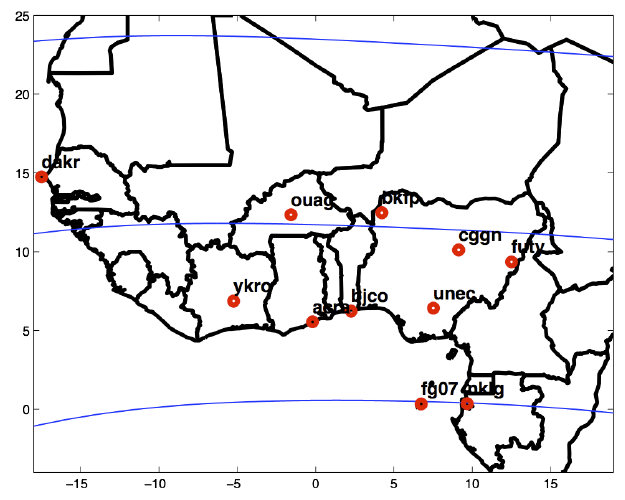
Figure 1. Distributions of GNSS receivers over central–western African equatorial and low-latitude region.